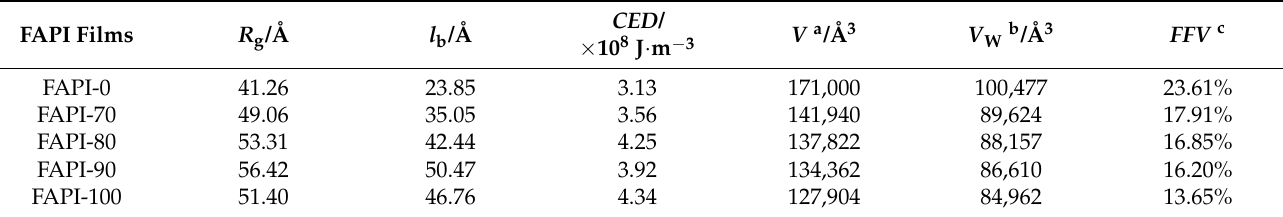
Table 6. Computational results of the FAPI